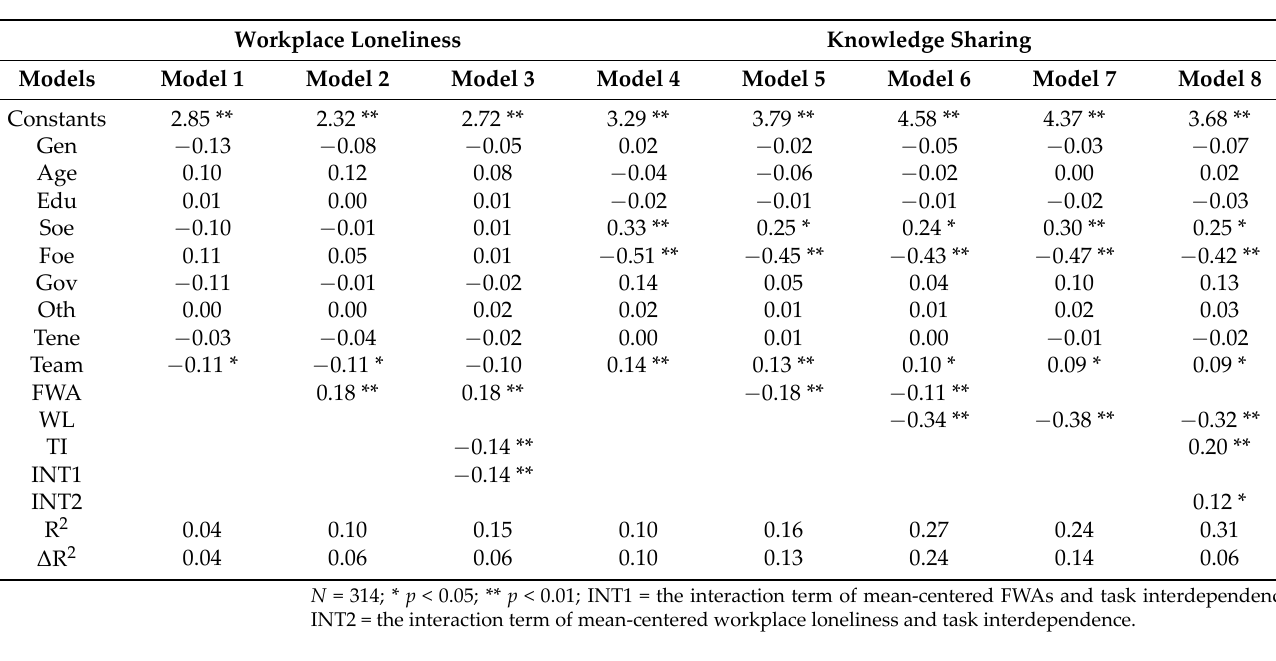
Table 2. Hierarchical regression analyses of Study 1.